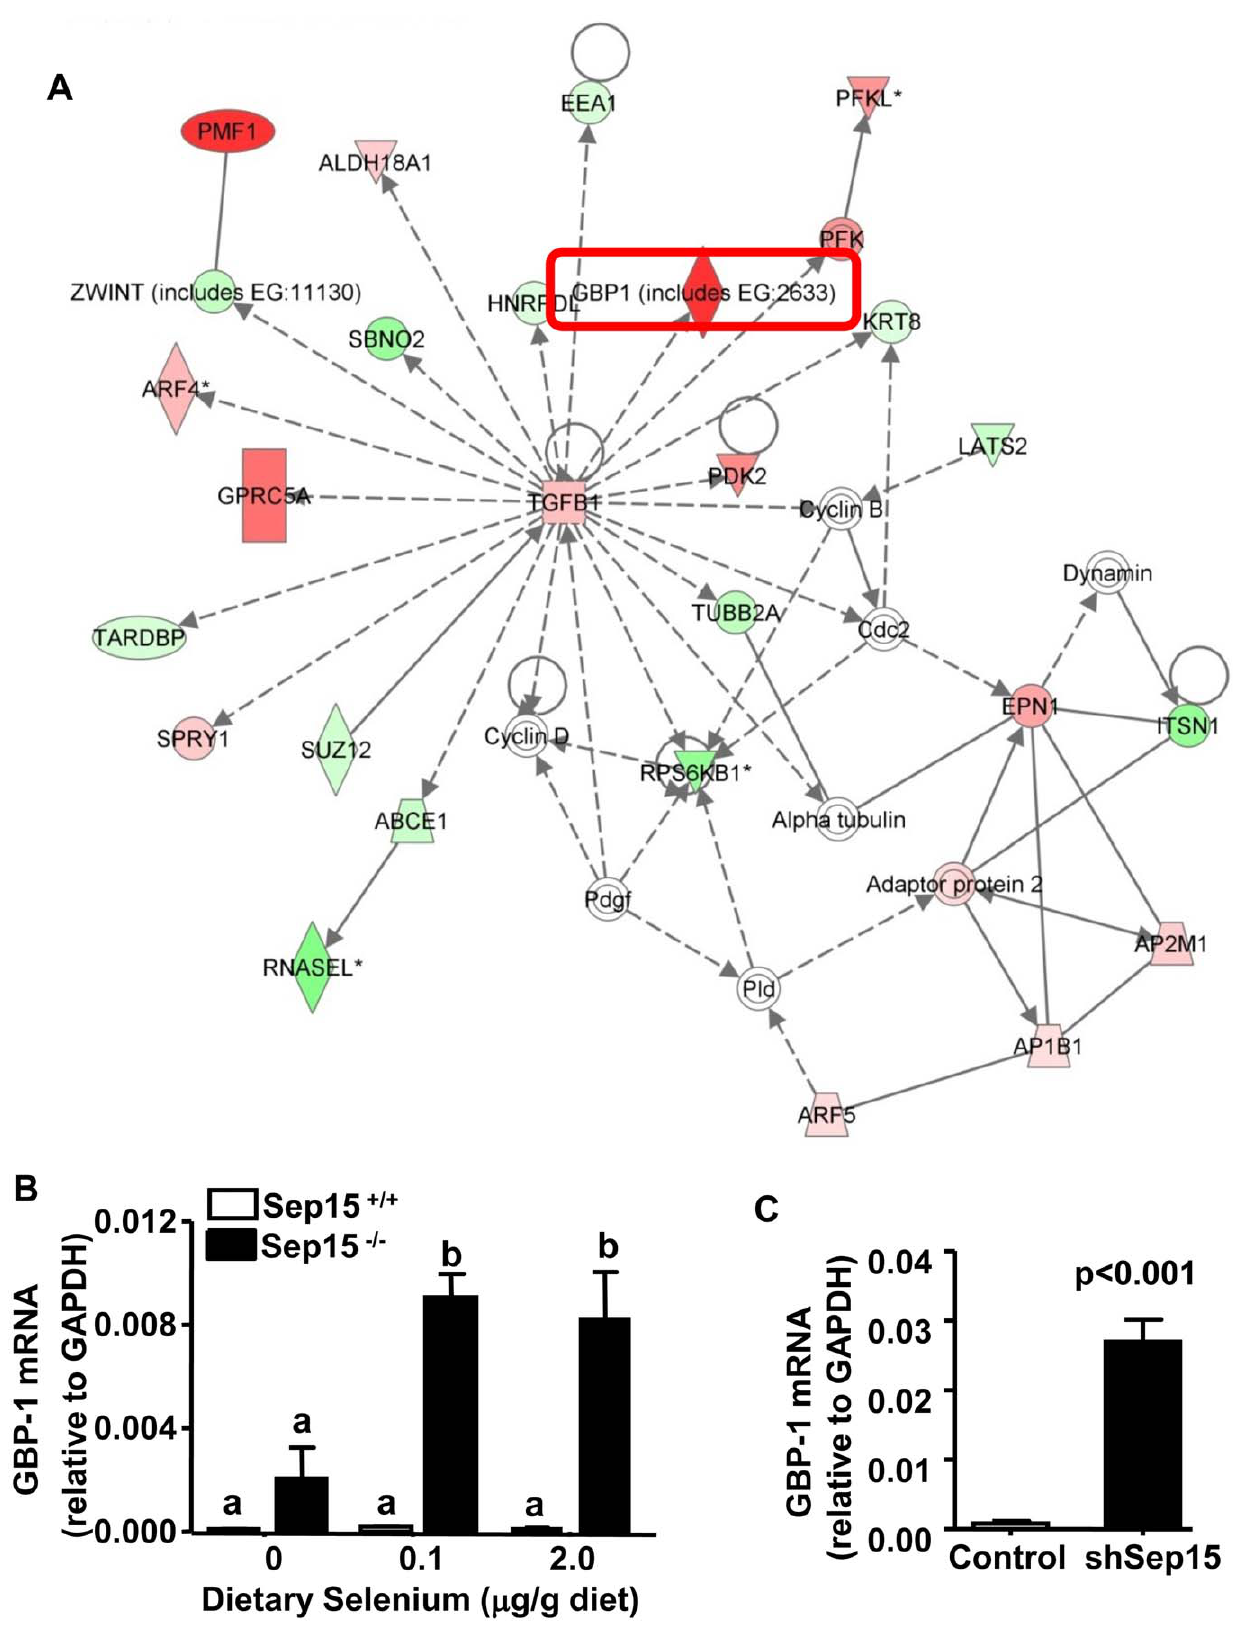
Figure 4. Ingenuity network analysis of genes regulated by knockout of Sep15 in mice and validation of GBP-1 mRNA expression in colonic epithelia of Sep15 knockout mice. (A) ‘‘Cellular development, growth and proliferation’’ was identified as the top affected network.